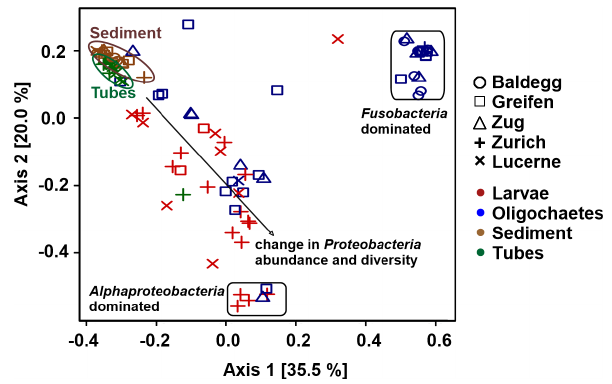
Figure 7. PCoA analysis of bacterial community structure at the order level using Bray–Curtis distances. All sediment 16S rRNA gene sequence data are from Han et al.